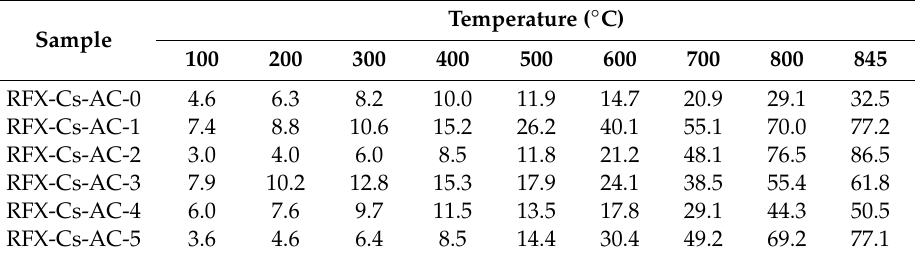
Table 2. TGA weight losses (%) of RFX-Cs-AC samples.